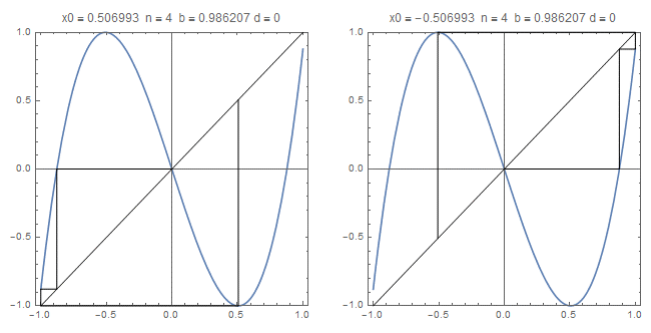
Figure 4. The graphics of f b , d with the trajectories of the critical points, c − and c + in the case b = 0.9862072184965917, d = 0, the kneading invariant is ( RRM ∞ , LLM ∞ ) . The growth number is √ s = 1 + 3 and r = 0.